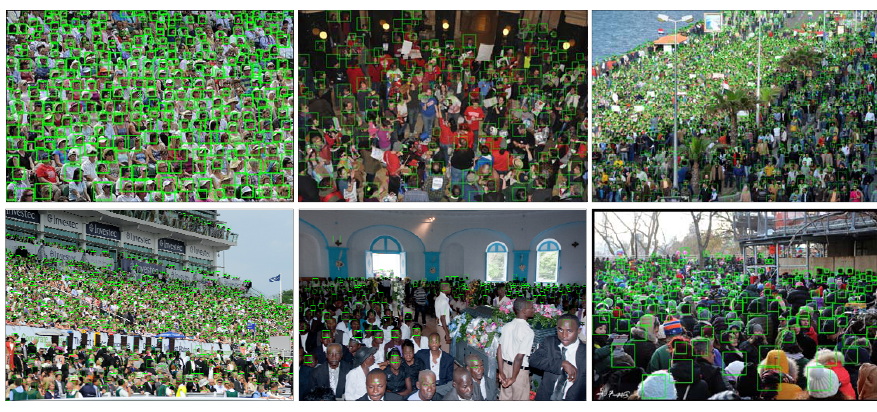
Figure 6. Qualitative results on the UCF-QNRF. Table 5. The comparison among the state-of-the-arts and our approach in UCF-QNRF. The best result is in